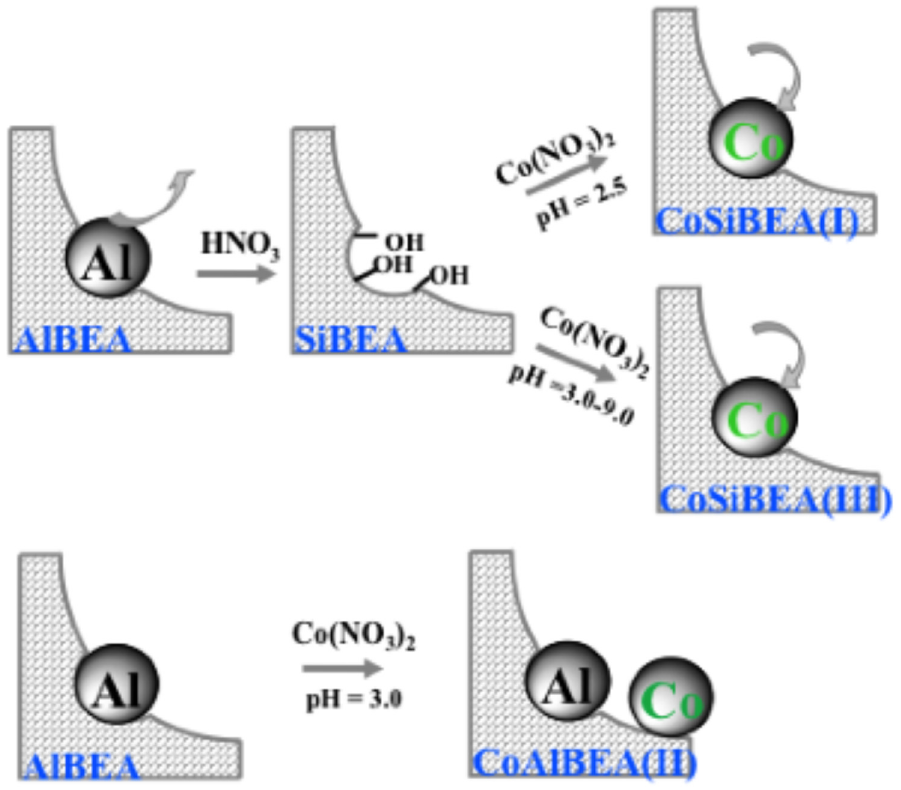
Figure 13. Diagram of each catalyst preparation.